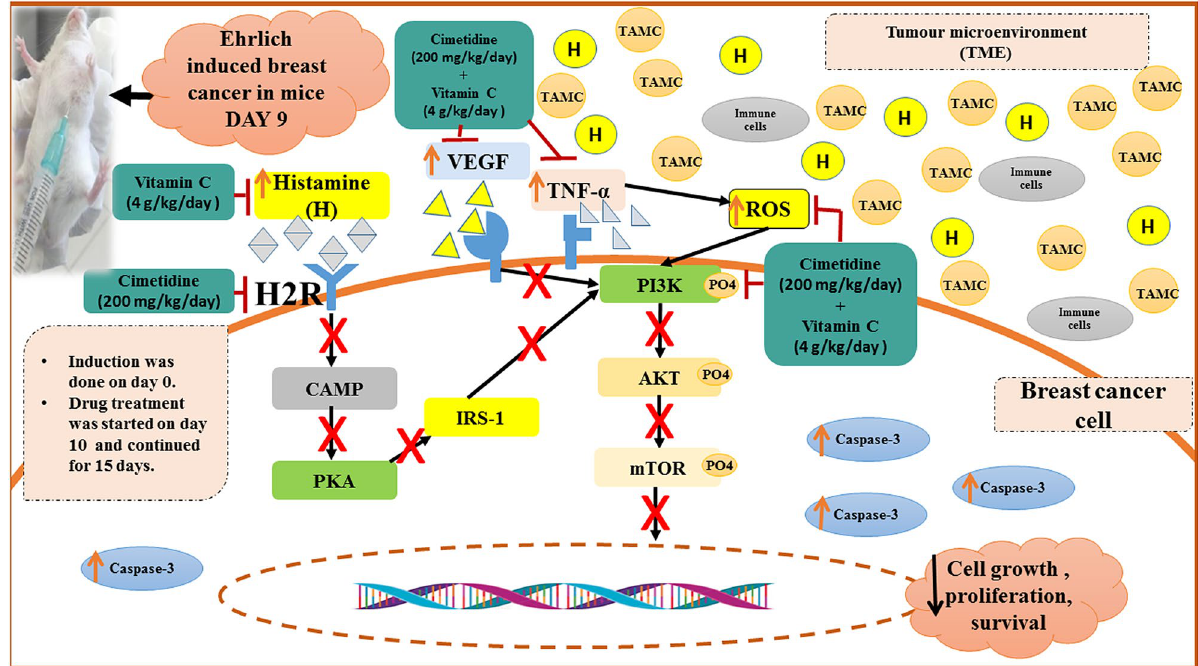
Figure 14. Shows the role of tumor-associated mast cells and their mediators (histamine, VEGF, and TNF- α) within the TME as well as the proposed mechanism of the anti-tumor effect of Cimetidine/Vitamin C by cell, TME tumour microenviroment, ROS reactive oxygen species, H2R histamine receptor 2, VEGF vascular endothelial growth factor, TNF‑α tumour necrosis factor alpha, cAMP cyclic adenosine monophosphate, PKA